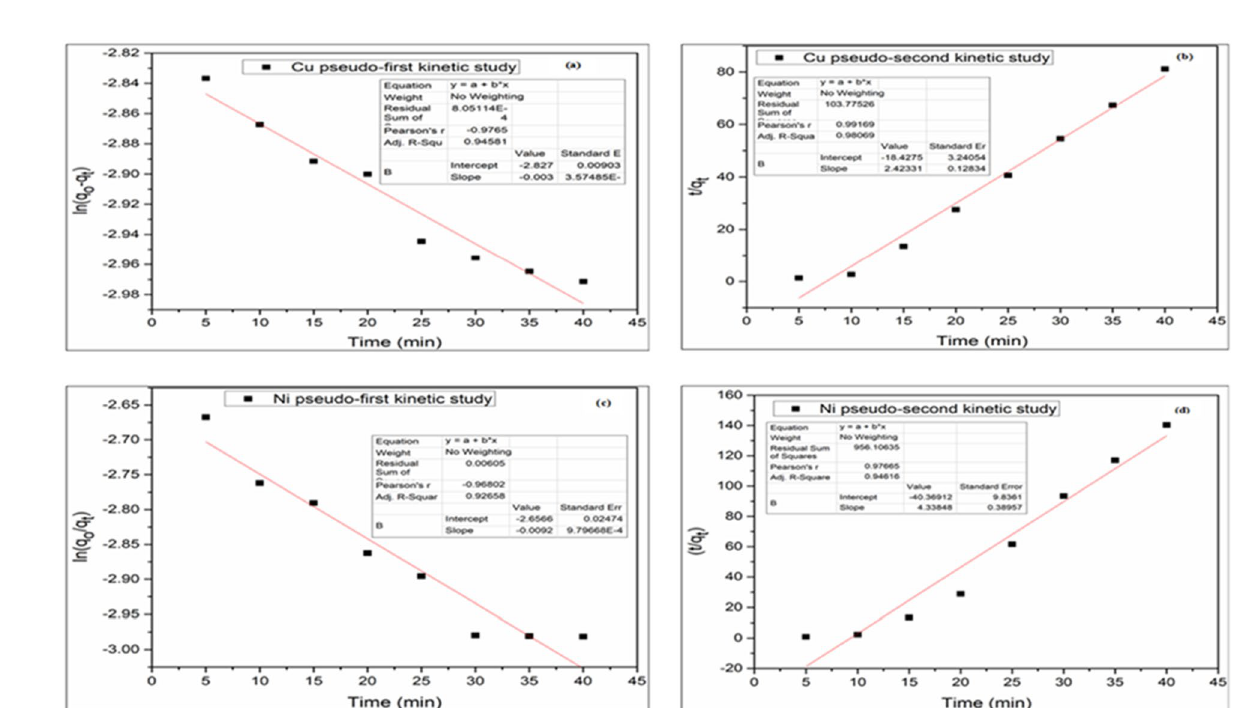
Figure 10. Adsorption/electrocoagulation Kinetic study ( a ) pseudo-first kinetic for Cu 2+ , ( b ) pseudo-second kinetic for Cu 2+ , ( c ) pseudo-first kinetic for Ni 2+ and ( d ) pseudo-second kinetic for Ni 2+